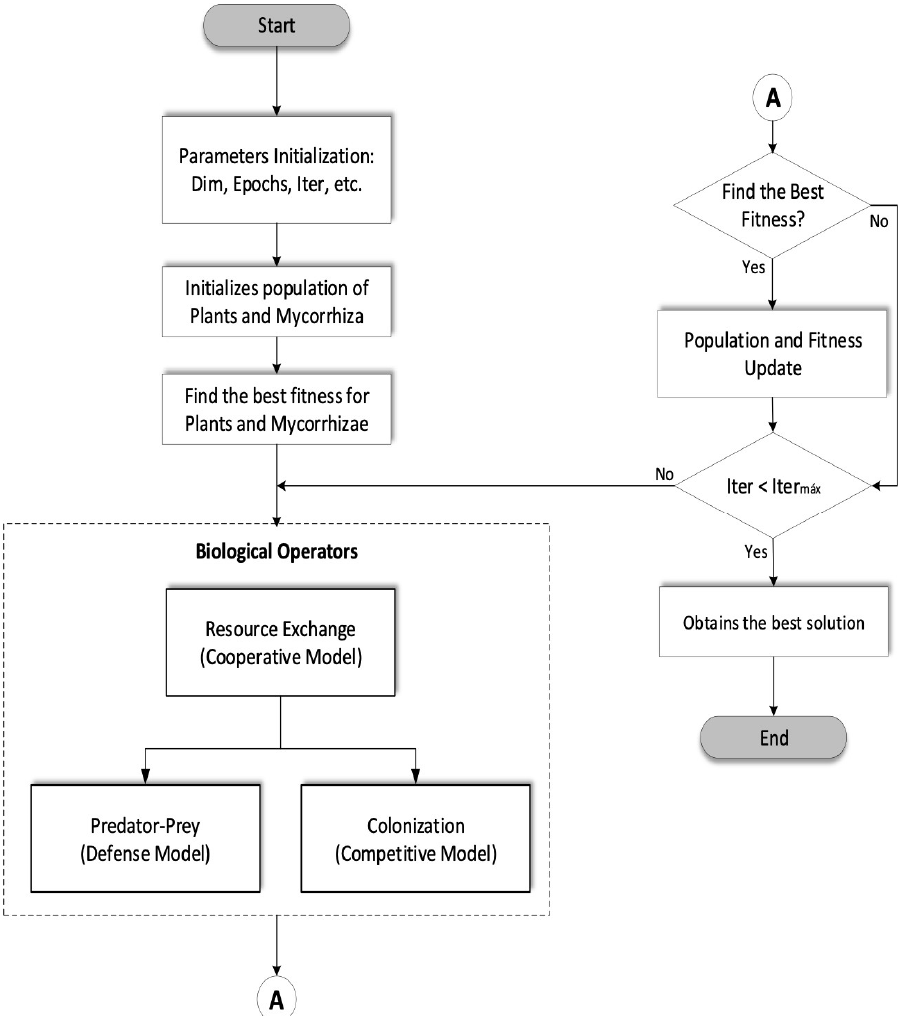
Figure 4. Flowchart of Discrete Mycorrhiza Optimization Algorithm—DMOA. Table 1. Lotka–Volterra Discrete Equation